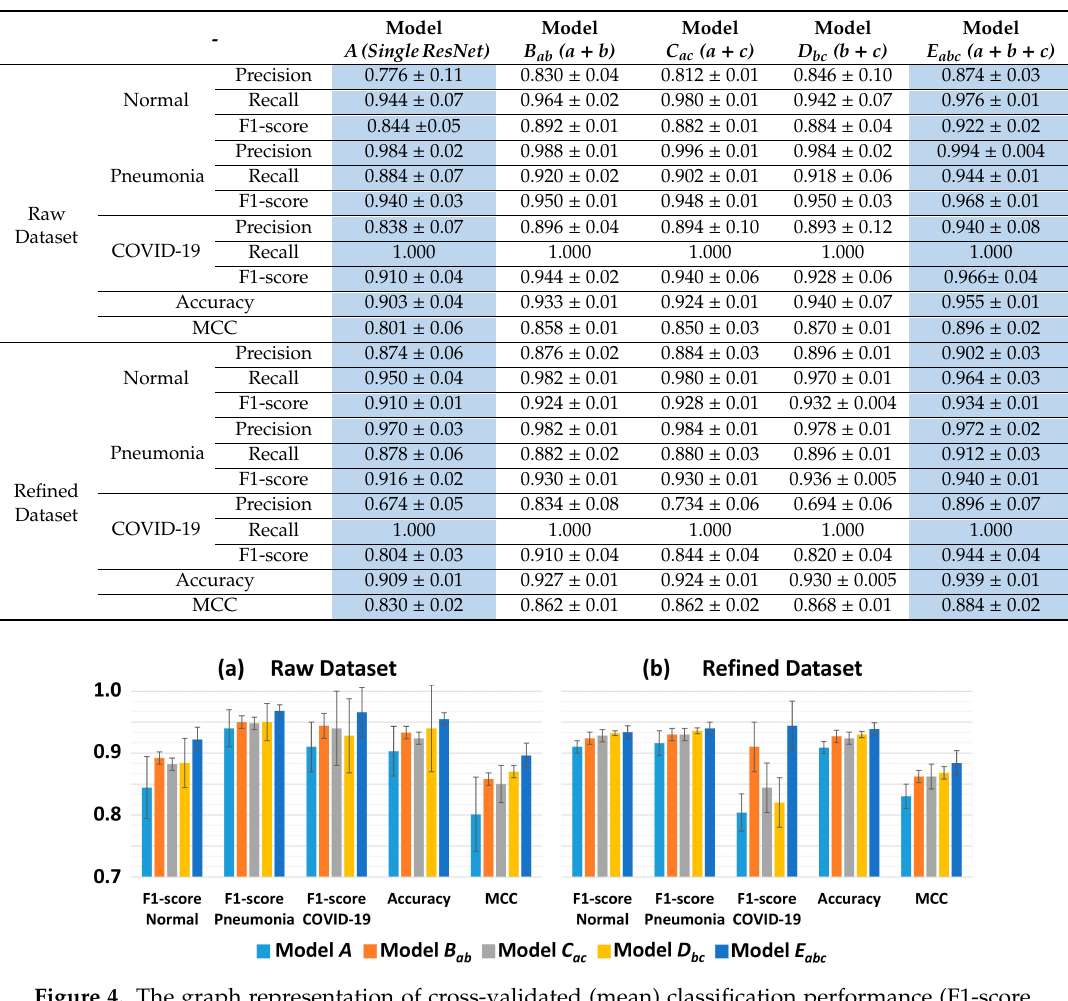
Figure 4. The graph representation of cross-validated (mean) classification performance (F1-score, accuracy, and MCC) for each model trained with the ( a ) raw and ( b ) refined datasets. The error bar represents the standard